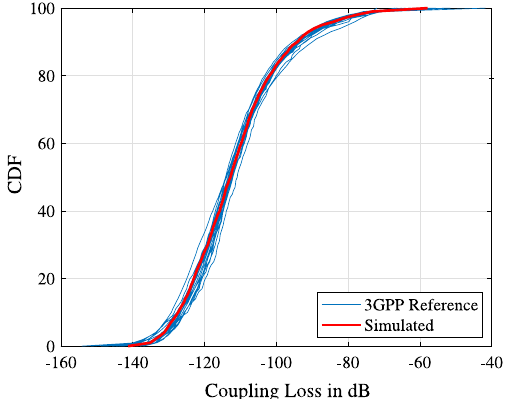
Fig. 9 Calibration of coupling loss with LMLC